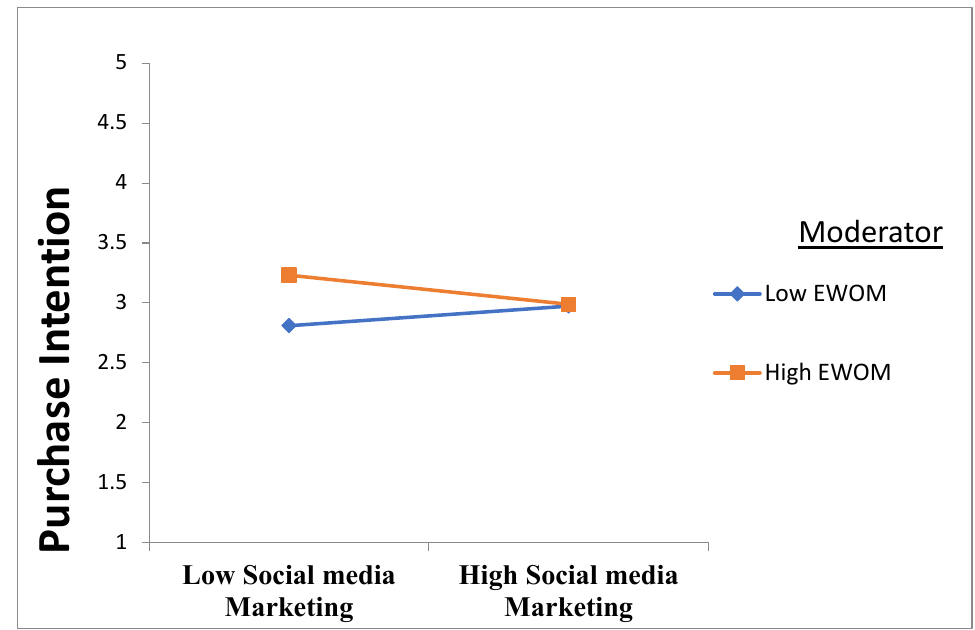
Fig. 4. Moderation effects of EWOM on the social media marketing and purchase